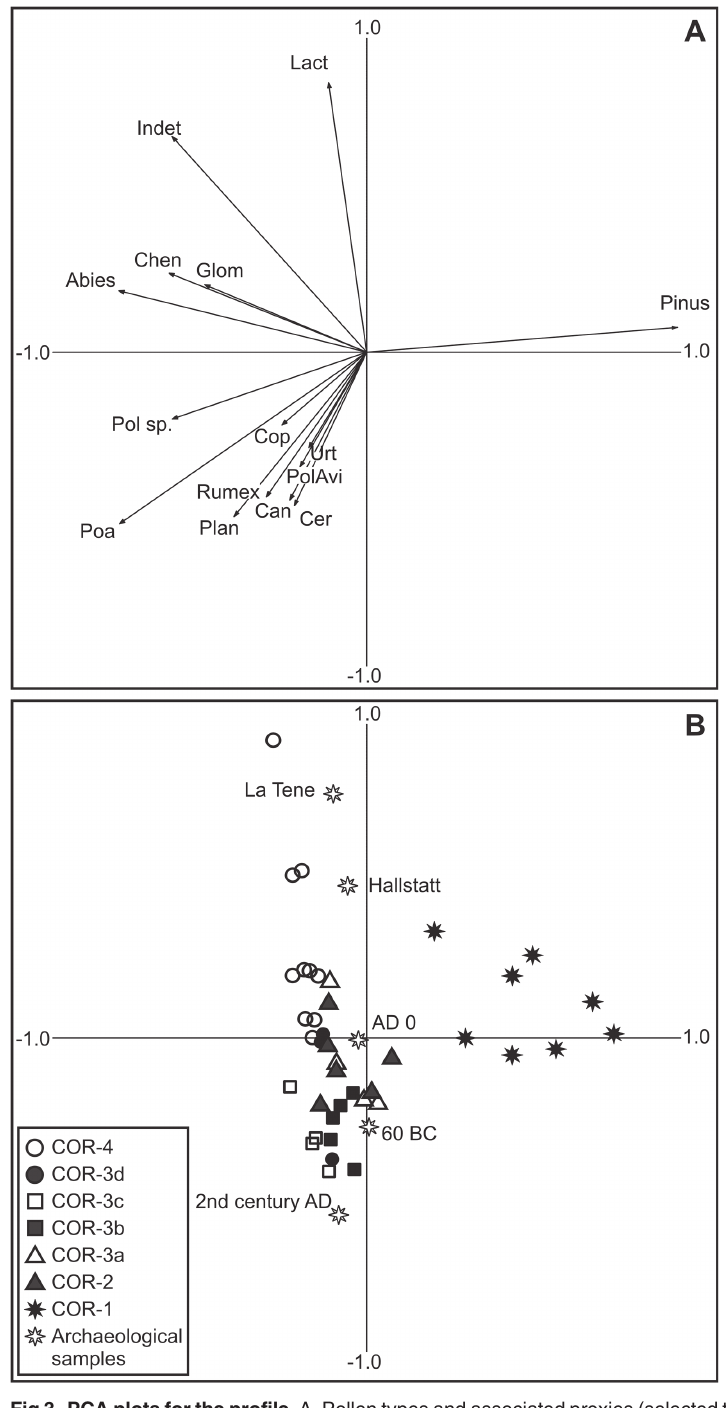
PLOS ONE | DOI:10.1371/journal.pone.0121517 April 8, 2015 8 /